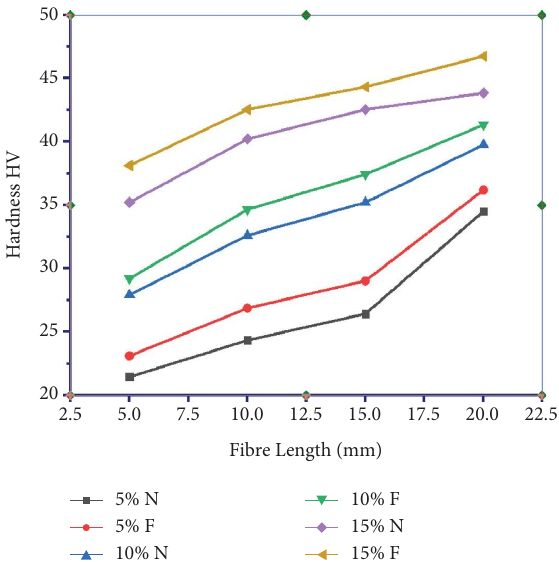
Figure 2: Composite hardness variation for diferent fbre wt.% and length (N-neat (without fller) and F (with fller)).